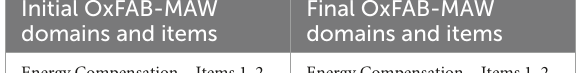
TABLE 2 Initial and final tool of Oxford Food and Activity Behaviors taxonomy (OxFAB-MAW) domains and items. Initial OxFAB-MAW domains and